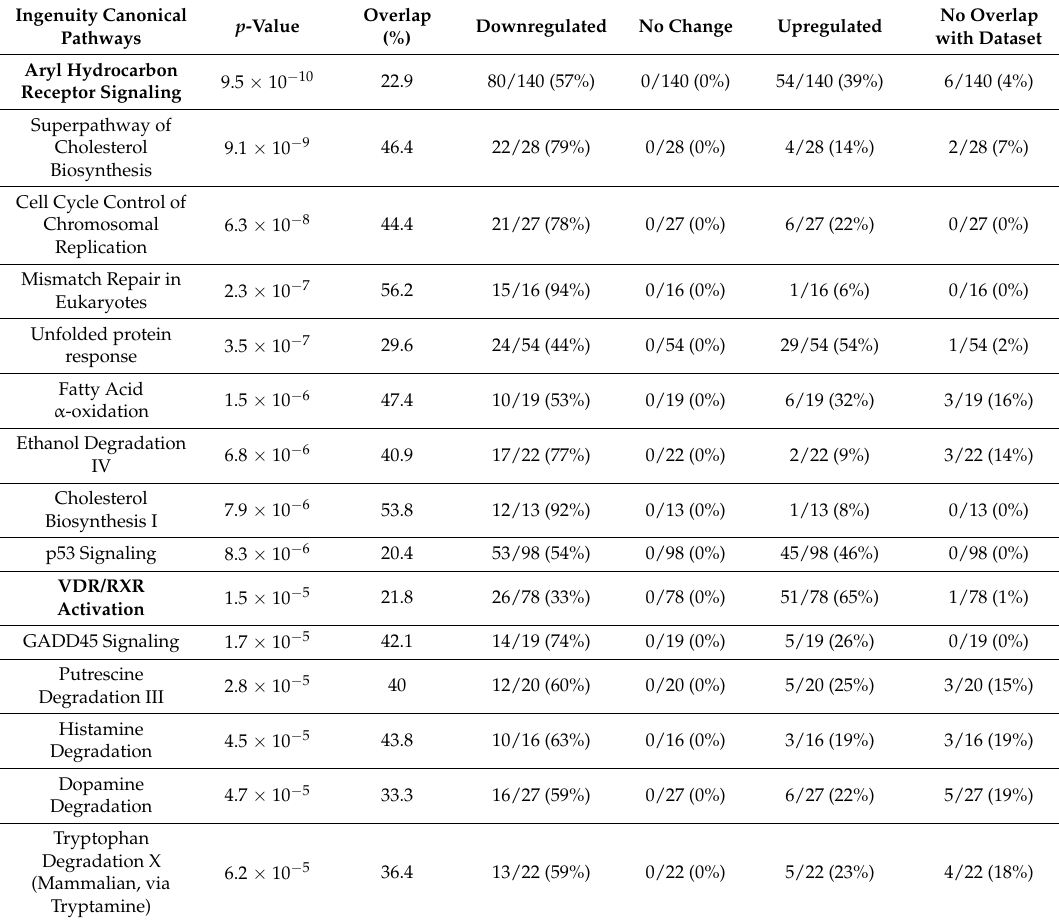
Table 9. Canonical pathways activated by 20,23(OH) 2 D3 in human epidermal keratinocytes after 24 h of treatment. Nuclear receptors are marked in